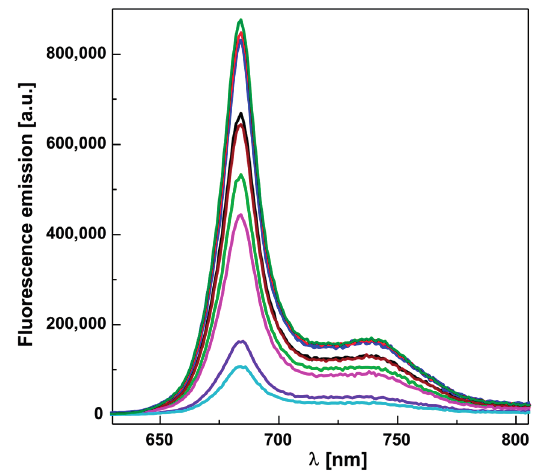
Figure 1. Fluorescence emission spectra of untreated spinach chloroplasts and those treated with 5 μ mol/dm 3 of studied compounds (from top to bottom: 4f —olive; 2c —red; 2a —blue; control sample—black; 3c —wine; 3e —green; 3b —magenta; 3d —violet; 2b —cyan).